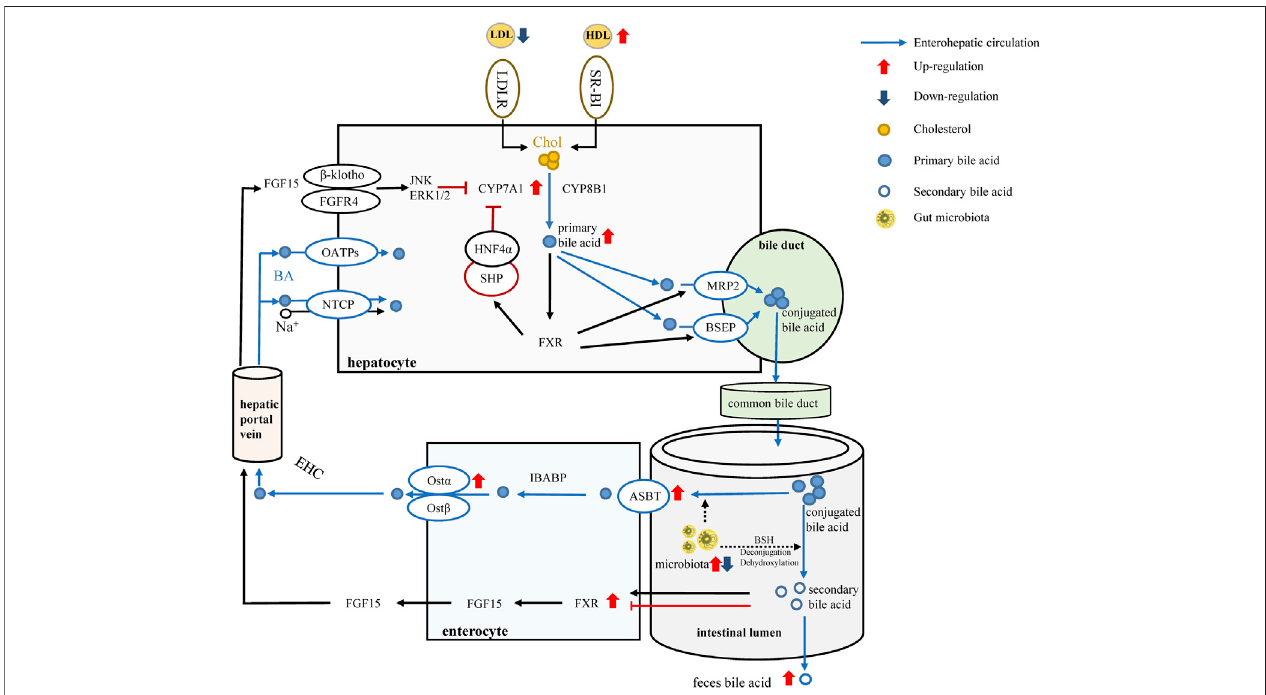
FIGURE 6 | LREE regulates bile acid metabolism through intestinal fl ora. Red arrows and blue arrows indicate up-regulation and down-regulation after LREE treatment. Normally, most of the primary bile acids are produced by cholesterol through the classical metabolic pathway involving CYP7A1 and CYP8B1. Primary bile acids form conjugated bile acids through the bile duct and are discharged into the intestine. Most ofthe conjugated bile acids are reabsorbed by the ASBT/OST system and participate in the enterohepatic circulation of bile acids. A small proportion of conjugated bile acids are deconjugated and dehydroxylated by microbiota, convertingto secondary bile acids. Different secondary bileacidscan activate or inhibit FXR and lead tothe release ofFGF15. Subsequently, FGF15 entered the liver via the hepatic portal vein to inhibit the expression of CYP7A1 and maintain bile acid levels together with the reabsorbed bile acids. LREE can restore the expression of ASBT, OST- α , FXR, CYP7A1 affected by hyperlipidemia, restore the reabsorption of bile acids, and promote the conversion of cholesterol into bile acids. Meanwhile, LREE increases the synthesis of secondary bile acids and accelerates their excretion through intestinal fl ora. Increased bile acid metabolism will increase the rate of lipid metabolism and maintain lipid homeostasis in the